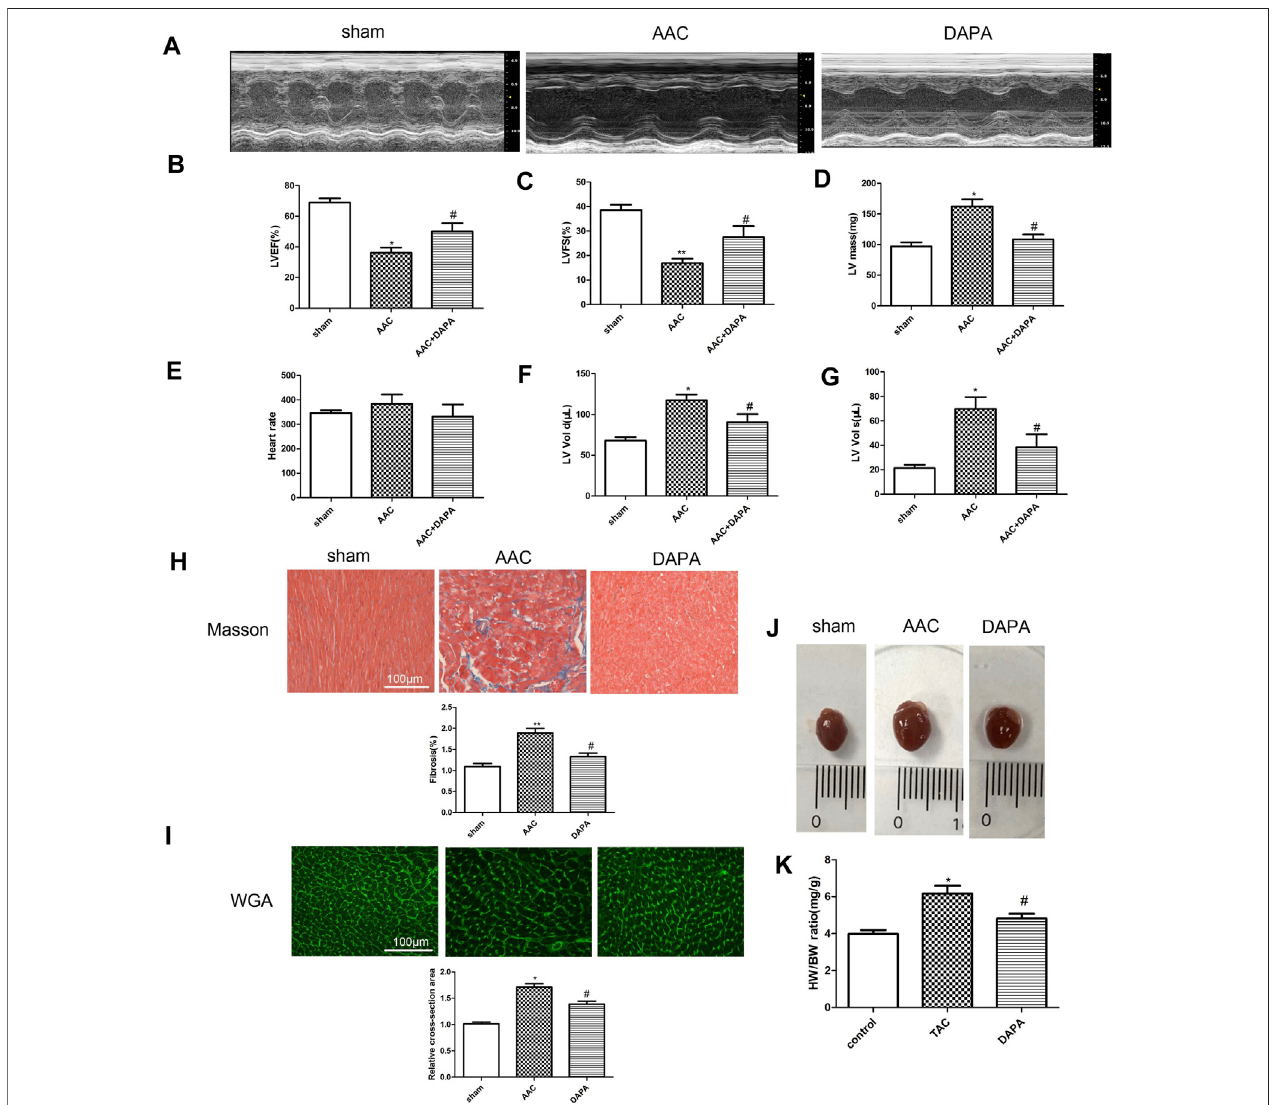
FIGURE 1 | Dapagli fl ozin alleviated cardiac remodeling and improved cardiac function in AAC-induced mice (A) Representative M-mode echocardiography images. In AAC-induced mice, dapagli fl ozin improved ejection fractions (EF) (B) and fractional shortening (FS) (C) , LV mass (D) , Heart rate (E) , LV end-diastolic volume, LVEDV (F) ,LVend-systolicvolume,LVESV, n (cid:1) 8 (G) .ImagesofMasson-stained (H) andWGA-stainedsections (I) indifferentgroups, n (cid:1) 3,originalmagni fi cation,400 × (J) Imagesofwholeheartfrommiceindifferentgroupsafter28 days. (K) Theheartweighttobodyweightratiowasdetermined, n (cid:1) 8.Thedatawereexpressedas mean ± SD, * p < 0.05, vs. sham group; # p < 0.05, vs. AAC group.